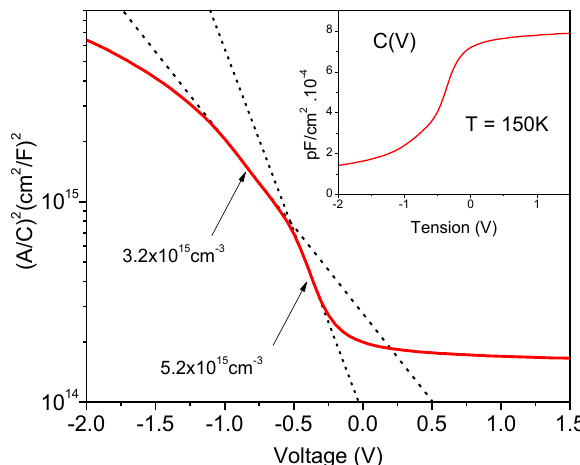
Figure 11. Capacitance-voltage measurement of a Ga-free T2SL nBn detector at T = 150 K. 1/C 2 (V) characteristic and in inset, surface capacitance C surf (V) curve.